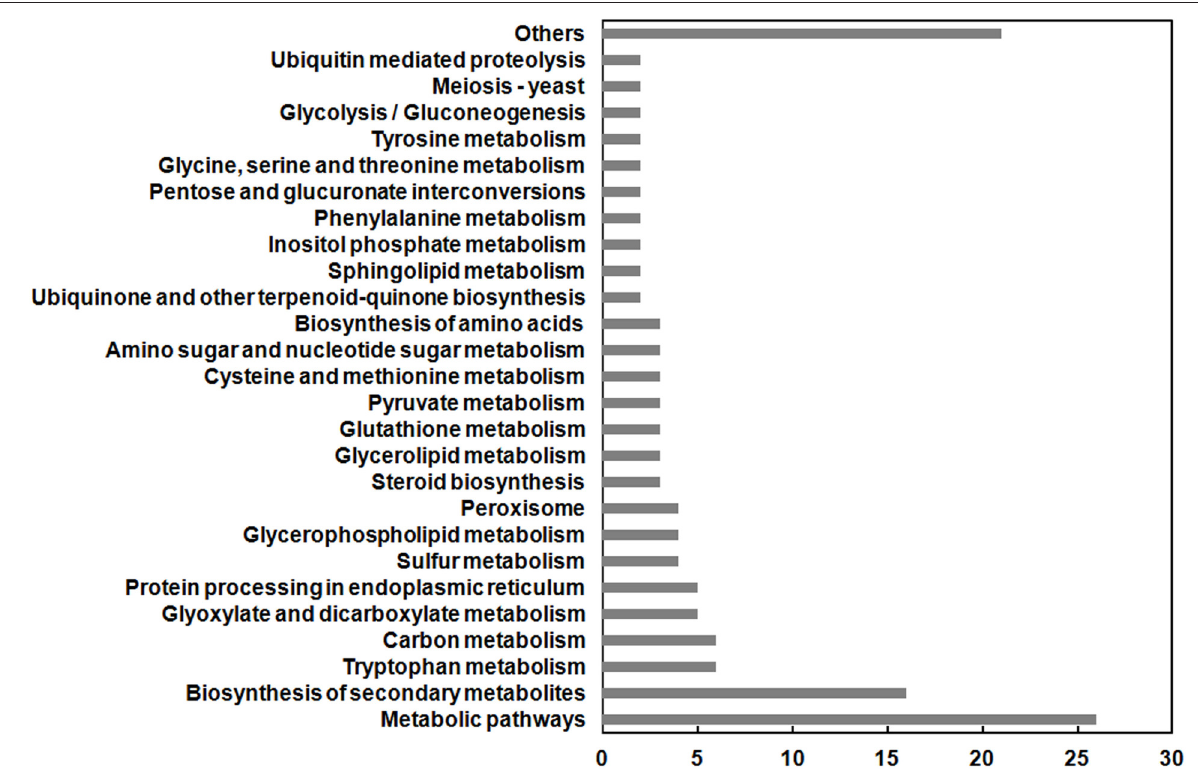
Frontiers in Microbiology |